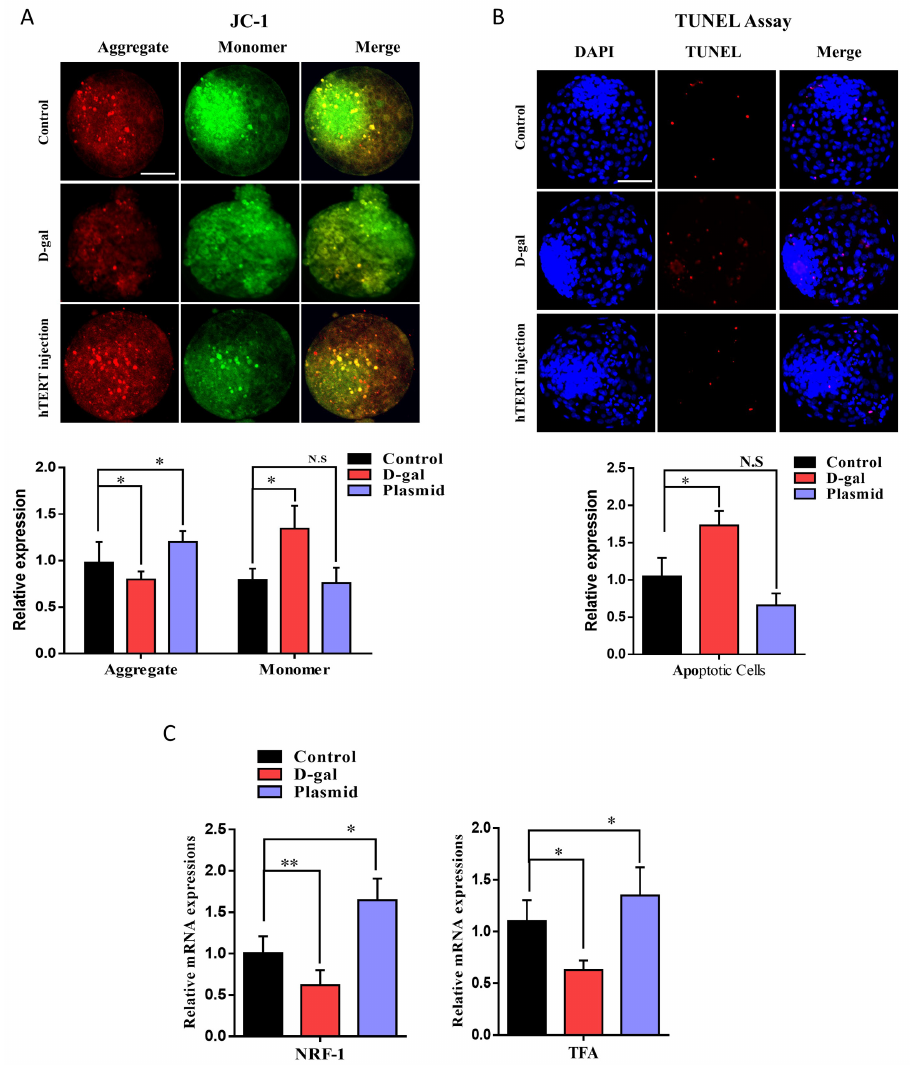
Figure 4. Enhanced telomerase expression amplifies mitochondrial genes and improves mitochon- drial potential. ( A ) JC-1 staining in day-8 blastocysts from the control, D-galactose, and hTERT-treated groups (20 per each group) and Bar = 100 µ m. ( B ) TUNEL assay was performed to detect apoptotic cells. The D-galactose group had significantly more TUNEL positive cells than the control and TERT plasmid injected groups ( n = 20 per group) and Bar = 100 µ m. ( C ) The relative mRNA expressions of NRF-1 and TFA in bovine day-8 blastocysts. The expression of both the genes were significantly reduced in D-gal group as compared to control and Plasmid groups. The data shown here as a mean ± S.E.M. N.S, not significant, * = p < 0.05, and ** = p <